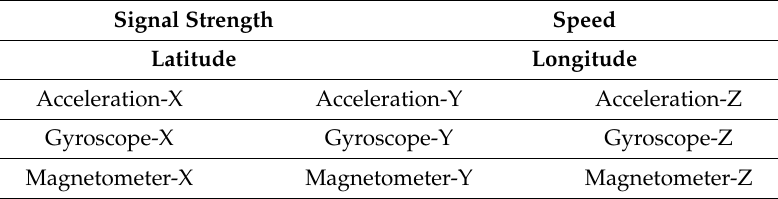
Table 2. Complete data structure for the dataset utilised in this